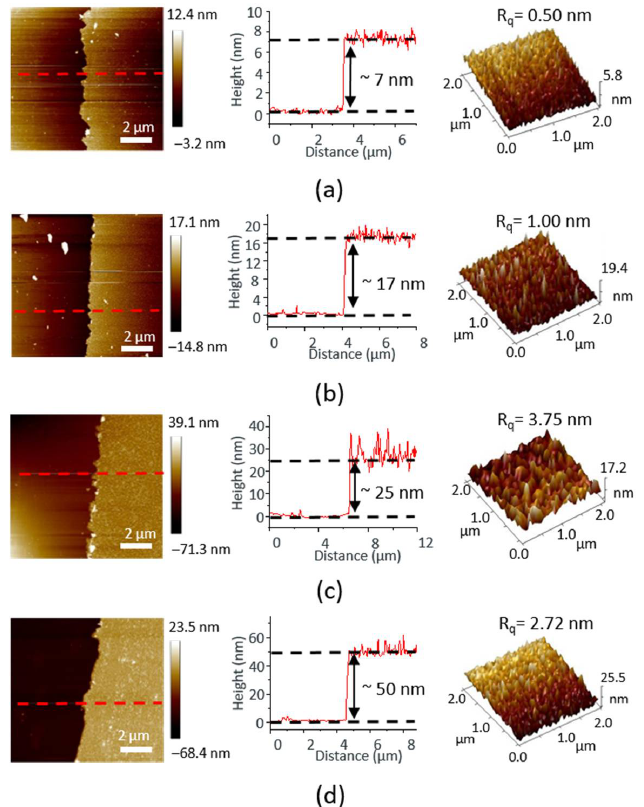
Figure 2. The AFM images (first column), height profiles (second column), and surface roughness (third column) of MoS 2 TFs on a sapphire substrate with different thickness: ( a ) 7 nm, ( b ) 17 nm, ( c ) 25 nm, and ( d ) 50 nm, respectively. The thickness of MoS 2 TFs was measured along the marked red lines.